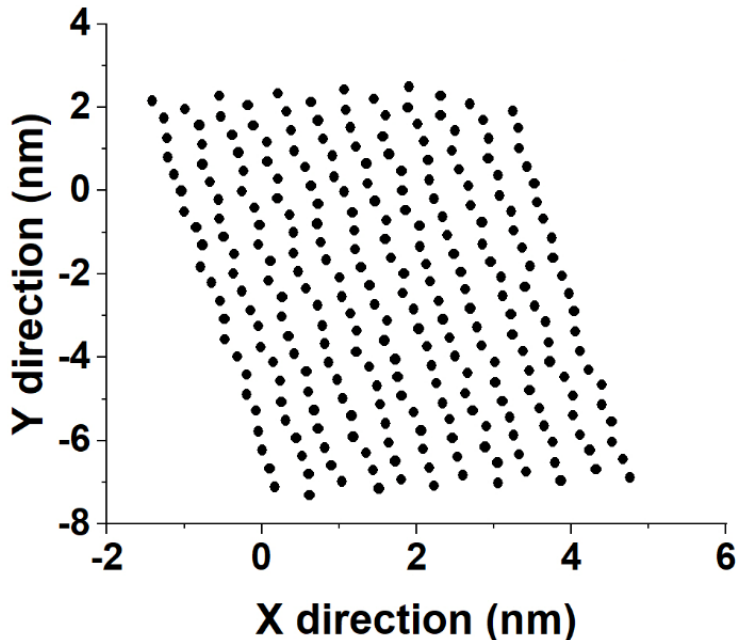
Figure 7. Illustration of the obtained in–plane coordinates of the intersection points of alkyl chains with the plane of crystallite 2 in the bulk HEX system at 278 K in the last frame of the MD trajectory. For convenience, we also rotated the points to lie in the xy plane of the coordinate system. This was done by applying a rotation matrix on the coordinates of the